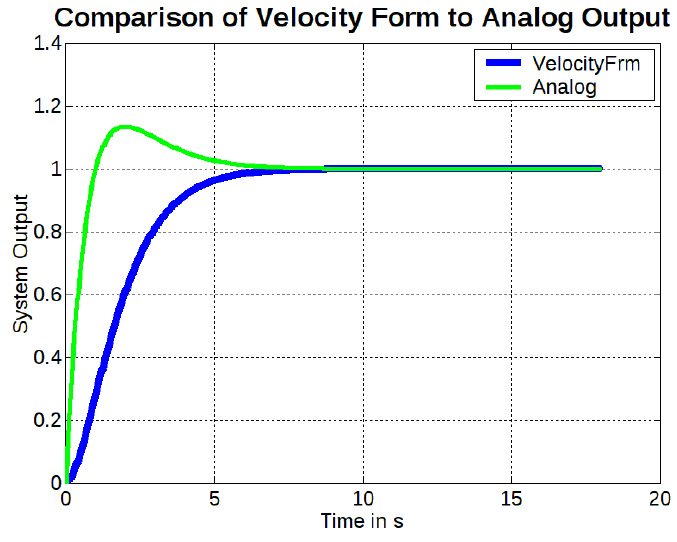
Figure 24. Velocity form PID compared to Analog PID.